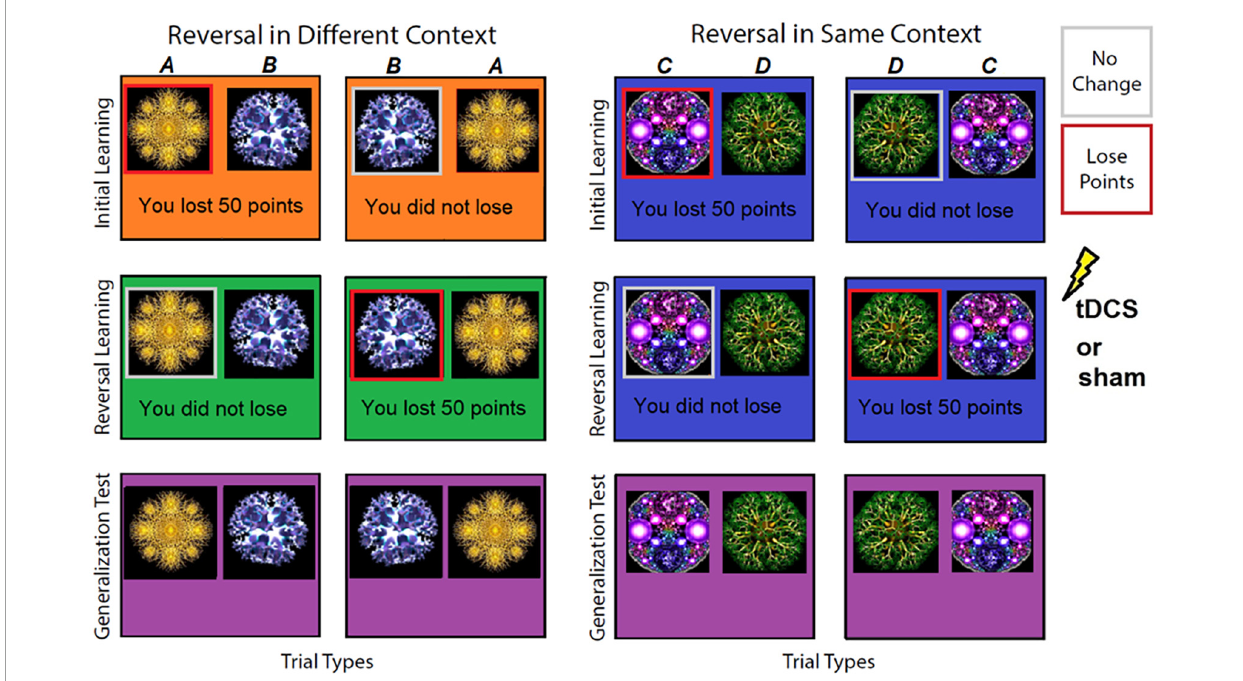
FIGURE1 Examples of stimuli and contexts used in the avoidance-based association learning task phases. In the initial learning phase, participants saw two sets of images in either Context 1 (orange background) or Context 2 (blue background). Selecting one image resulted in a 50-point loss on 80% of trials [images (A,C) , highlighted in this figure with a red square; square was not shown to participants] or resulted in no points lost [images (B,D) , highlighted in this figure with a gray square; square was not shown to participants]. During reversal, these contingencies reversed so that the image that previously resulted in a 50-point loss 80% of the time now resulted in no loss, and vice versa, the image associated with no points lost now led to a 50-point loss on 80% of trials. This reversal occurred in either a different context (Context 3, green background) or the same context (Context 2, blue background) as the initial learning phase. During the generalization test, previously presented image pairs were presented in a never-before- seen Context 4 (purple background) and participants were asked which image they